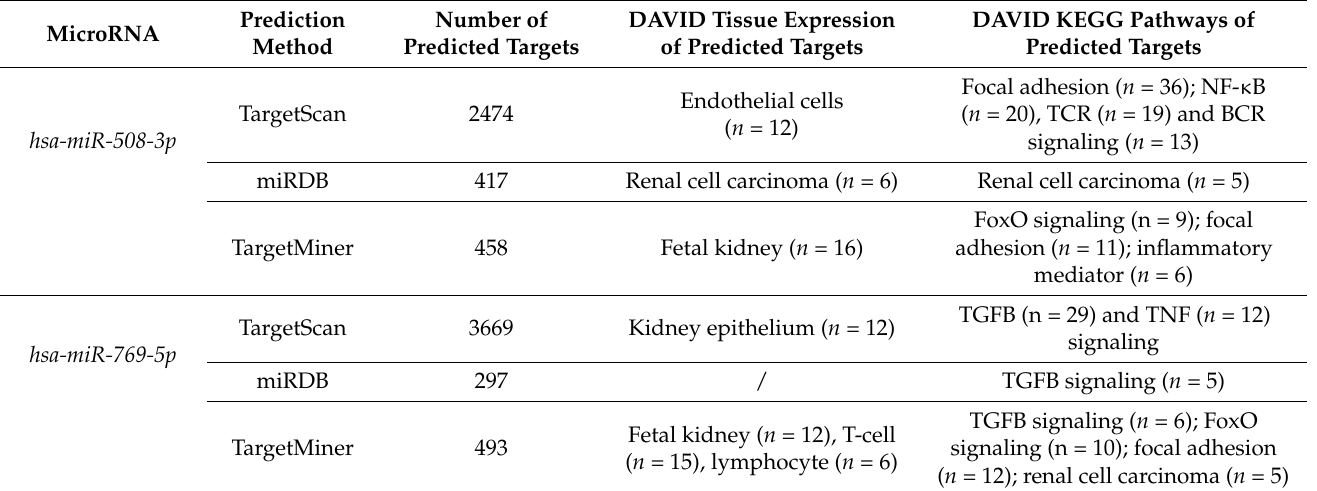
Table 5. Target prediction for two AAV-specific